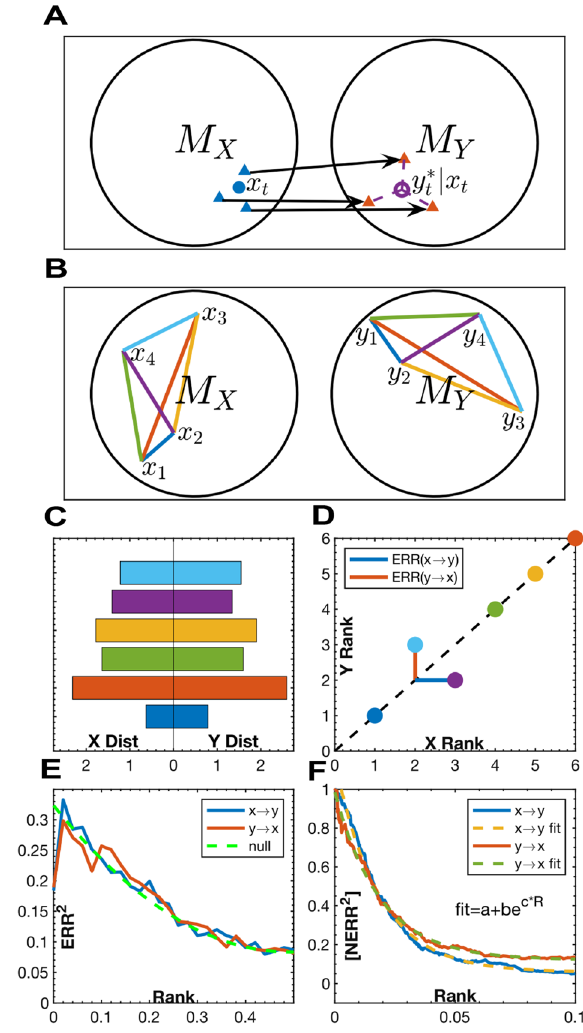
Figure 7. ( A ) An illustration of the CCM method. x t is point in M X . The blue triangular markers represent its D + 1 nearest neighbors where D is the embedding dimension. The arrows show the mapping of each ∗ | x neighbor in M X to its location in M Y . y t t is the estimate of the point y t from exponentially weighted ∗ , y average cross mapped neighbors from x t . CCM (cid:31) y → x (cid:30) = corr (cid:31) y t t (cid:30) ( B–F ) An illustration of the CCS method. ( B ) Pairwise distances between the same four timepoints in M X and M Y colored according to which time points they span. ( C ) The magnitude of the distances in both manifolds. ( D ) The rank of each distance in M X , R X , plotted against its rank in M Y , R Y . The black dashed line represents perfect correspondence. The blue and red lines show the error between ranks, ERR = R X - R Y , as a function of R Y and R X , respectively. ERR (cid:31) x → y (cid:30) = ERR ( R Y ) and ERR (cid:31) y → x (cid:30) = ERR ( R X ) because they measure how well ranks in the manifold of the driven variable predict ranks in the manifold of the driver. ( E ) ERR 2 as a function of rank for a bidirectionally coupled logistic map. The ranks have been normalized between 0 and 1. The dashed green line represents the null expected ERR 2 for uncorrelated ranks. ( F ) The cumulative average of the normalized error, (cid:31) NERR 2 (cid:30) , as a function of rank, for the system shown in ( E ). NERR 2 = ( null − ERR 2 )/ null . (cid:31) NERR 2 (cid:30) is thresholded at a maximum rank and fit to an exponential curve. The CCS scores are given by the y-intercepts of the fitted curves. Extrapolating from the best fit curve improves the estimate of the local correspondence by leveraging information from larger scales to overcome the high variance in NERR 2 observed at very low